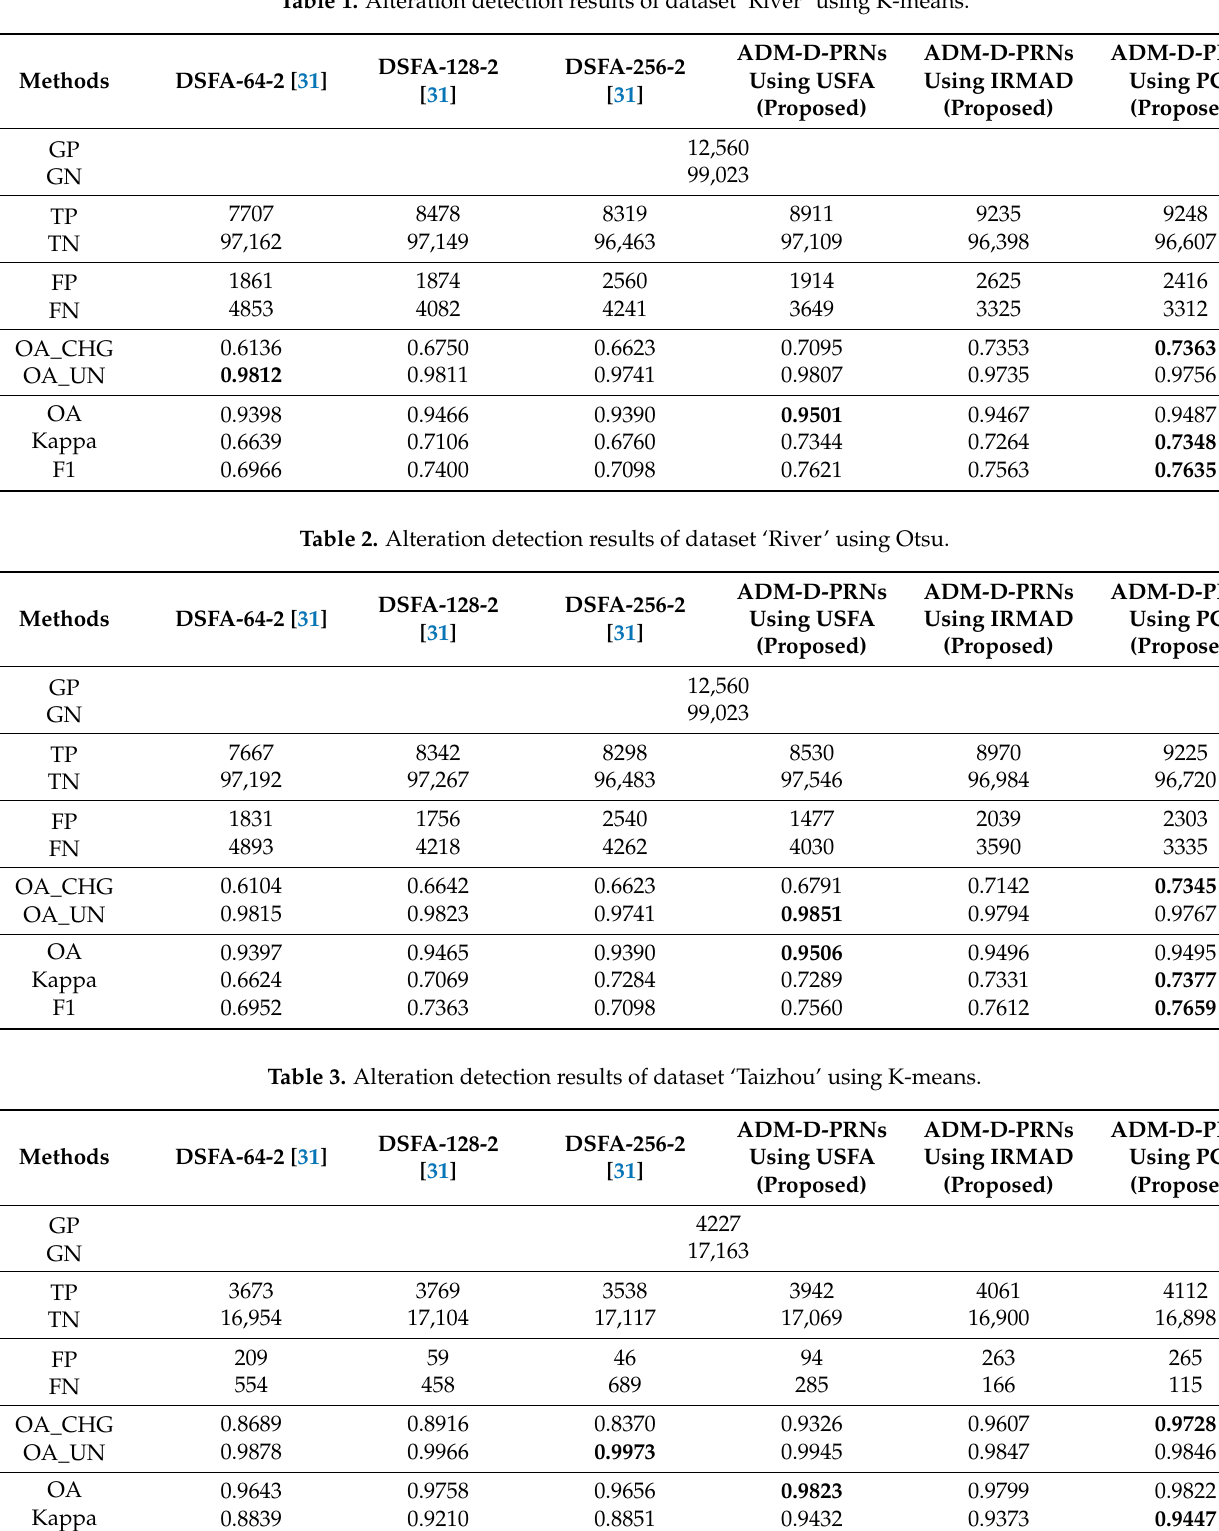
Table 1. Alteration detection results of dataset ‘River’ using K-means.